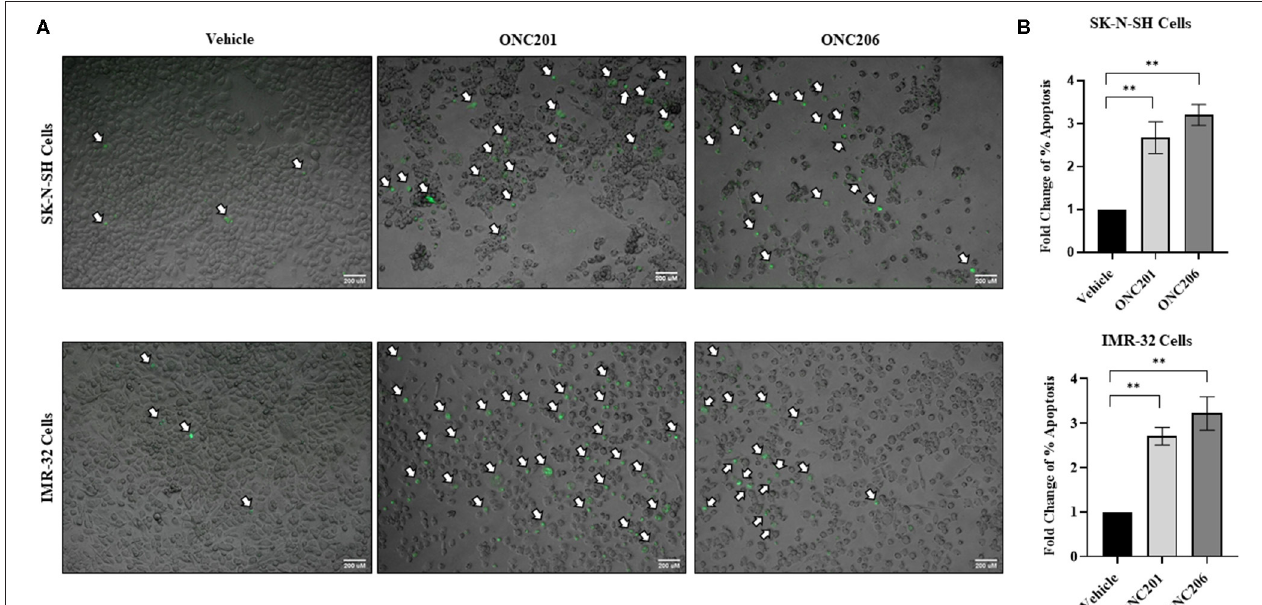
FIGURE 5 | Cellular apoptosis after ONC201/ONC206 treatment. SK-N-SH and IMR-32 cells treated with ONC201 (5 µ M) or ONC206 (0.5 µ M) exhibited a significant increase in the rate of cellular apoptosis as assessed using the CellEvent caspase3/7 staining 72h post-treatment. Green fluorescence represents apoptotic cells imaged at × 4 magnification (A) and relative fold change of percent apoptosis compared with vehicle-treated cells (B) . White arrows indicate fluorescent apoptotic cells. Experiments were conducted in triplicates and repeated three times. Scale bar 200 µ M. Data represent mean ± standard error of the mean (SEM) of multiple experiments. ** p <